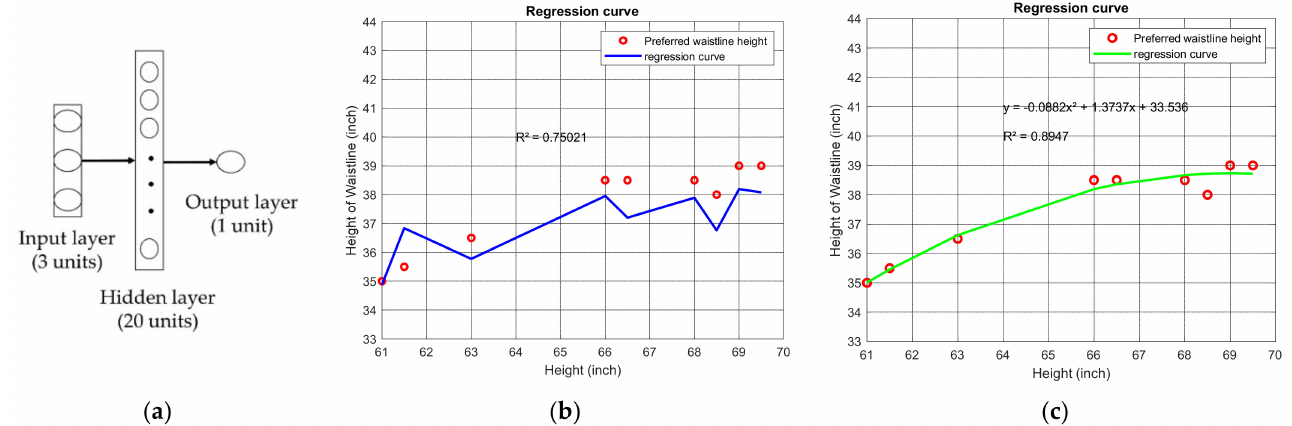
Figure 8. ( a ) Neural network model for estimating the heights of the waistlines of the users’ respective preferences and a regression curve obtained for prediction of the waistline using ( b ) a neural network and ( c ) polynomial fitting. Here, the red circles are the waistlines preferred by the individual subjects, and the blue and green curves are the regression curves, which were used to obtain the predicted waistline of the user’s own preference.